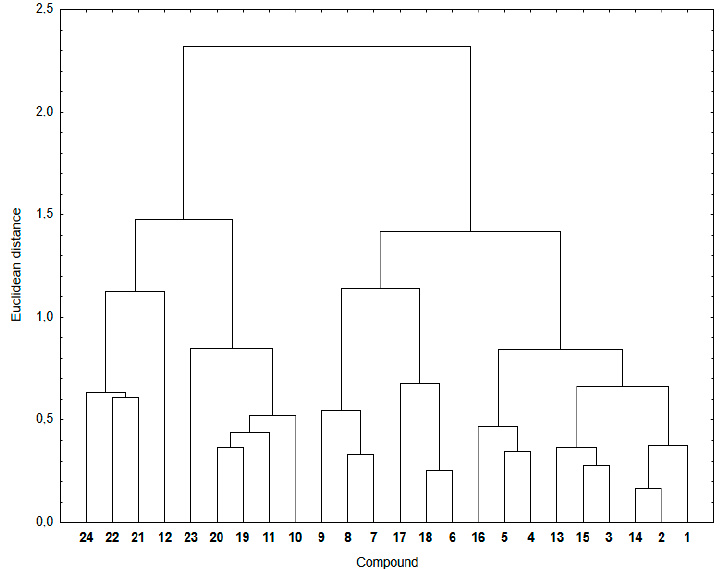
Figure 4. Similarity analysis for the experimental and theoretical lipophilicity for compounds 1 – 24 . 196 Table 5. The similarity parameter (ED) for experimental and calculated lipophilicity for hybrids 1 – 24